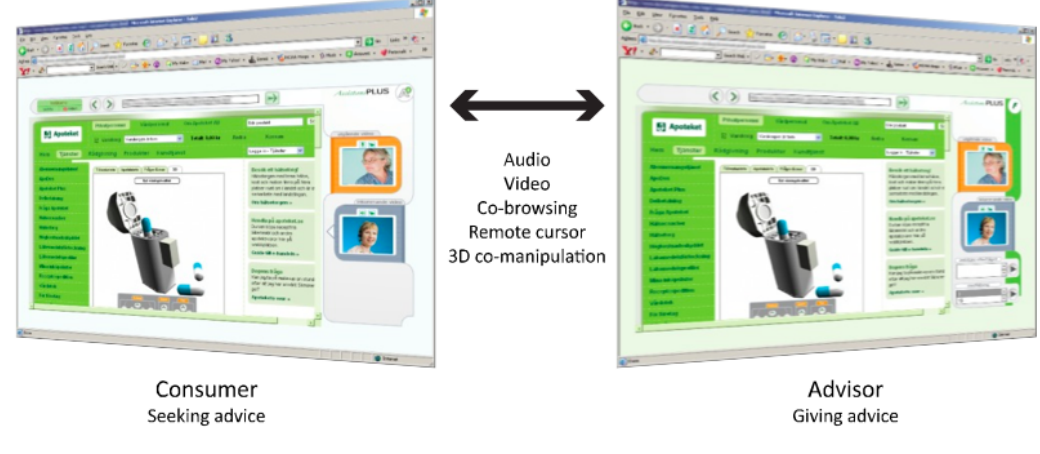
Figure 1. AssistancePlus, a tool for 3-dimensional (3D) -supported advice-giving on pharmaceutical products over